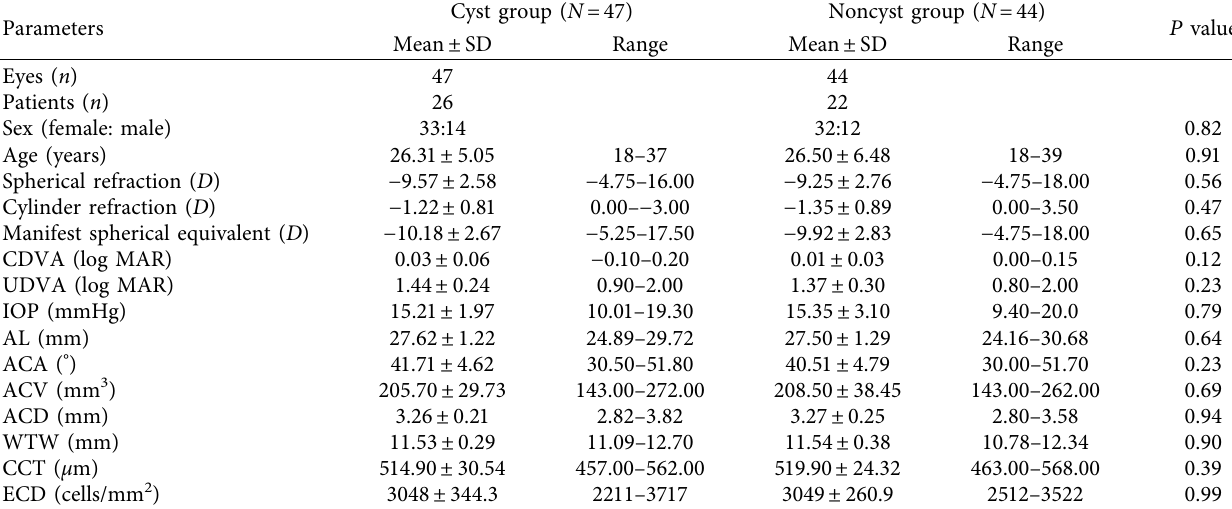
Table 1: Baseline preoperative and demographic indicators of the